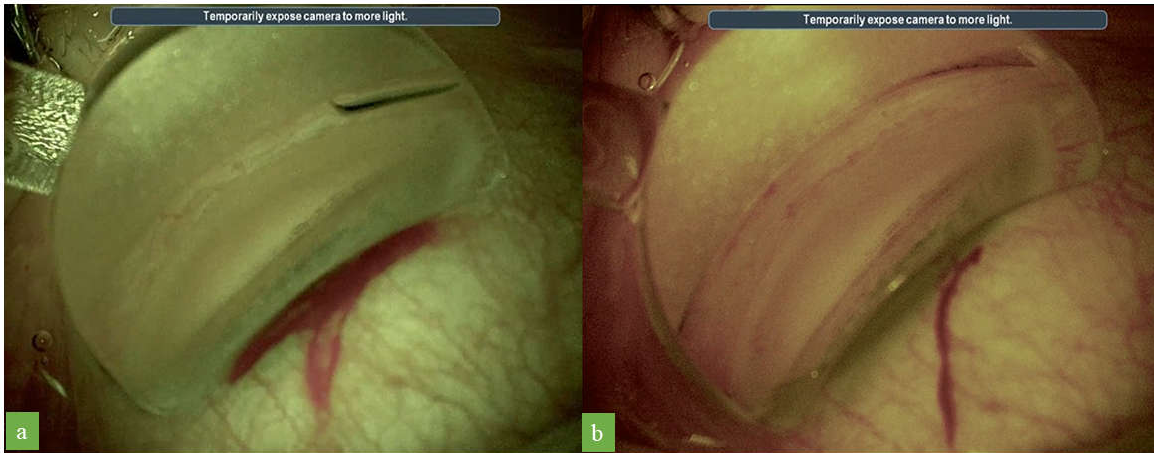
Figure 4. Images obtained during surgical gonioscopy with the optimized settings before ( a ) and after increasing color temperature ( b ). Schlemm’s canal is better visualized, and the addition of warm color tones leads to the canal appearing more red.